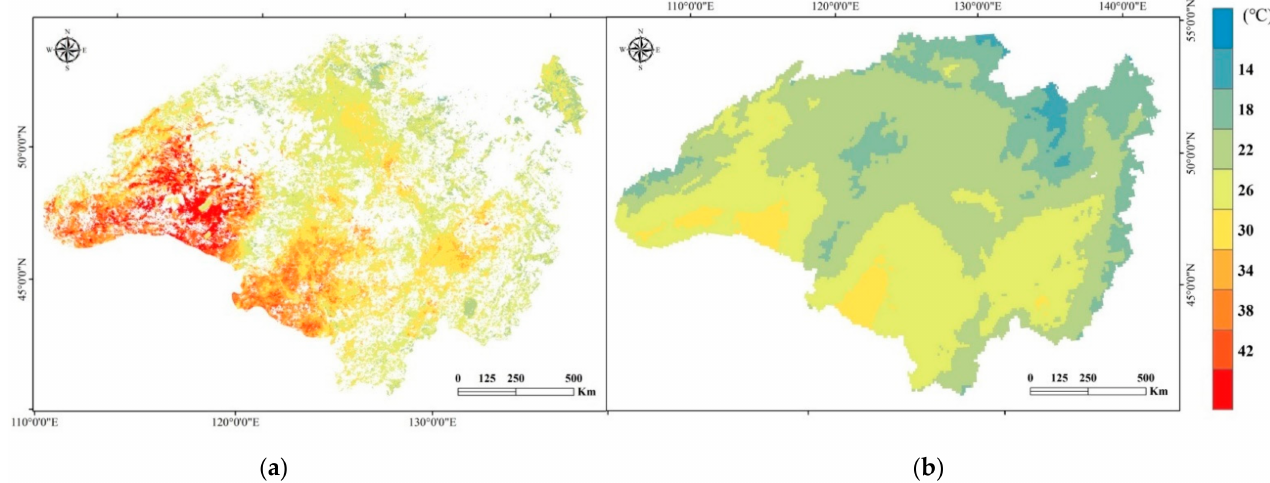
Figure 2. Example maps of MODIS LST ( a ) and ERA5ST ( b ) on DOY193 (12 July), 2010 at 10:30 a.m. local time. The gaps in ( a ) are missing